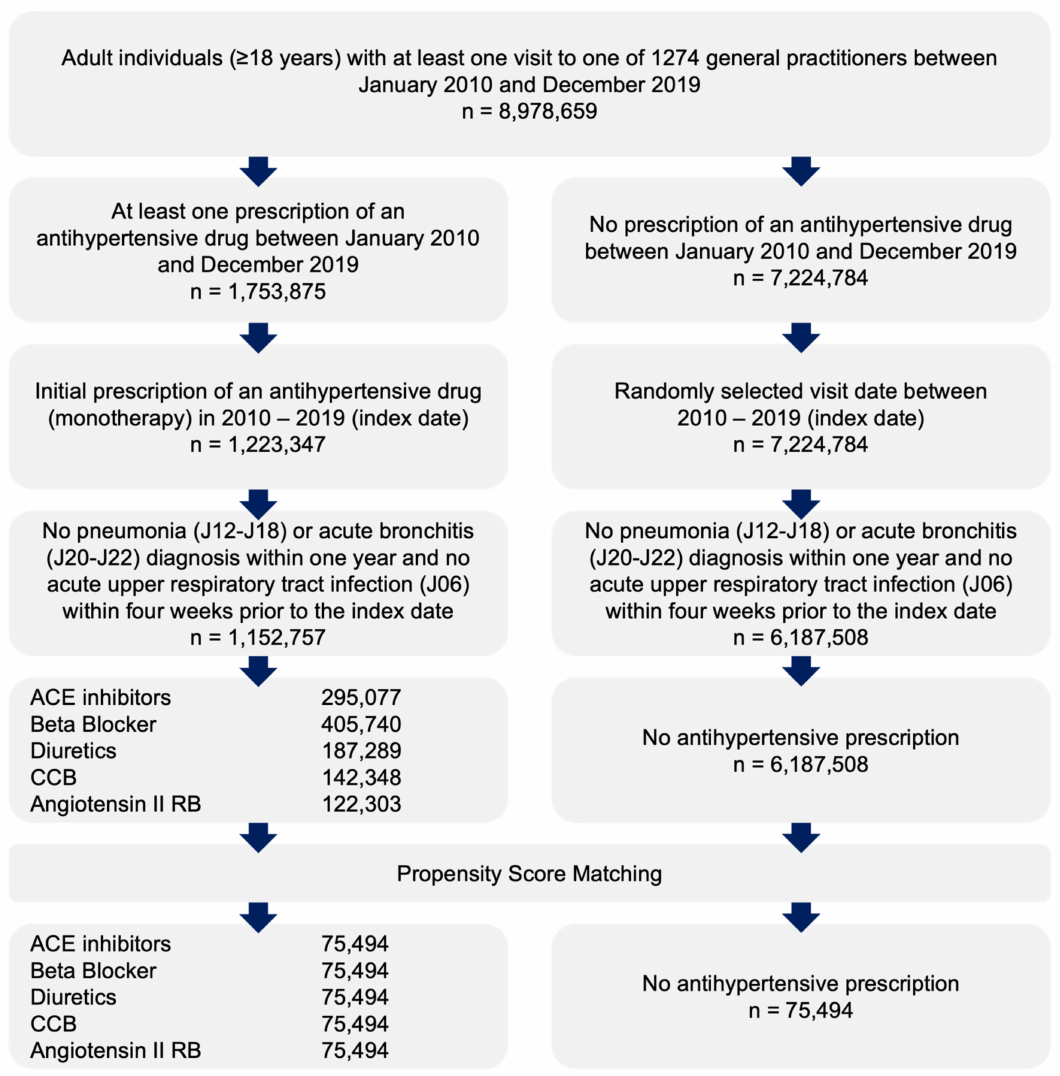
Figure 1. Selection of study